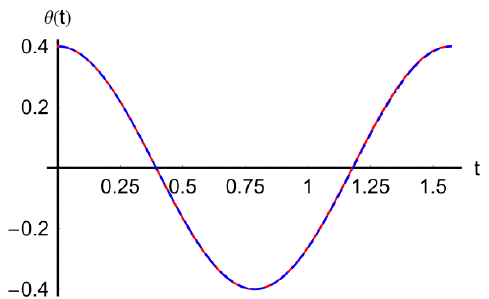
Figure 21. Phase plane for A = 0.4, L =